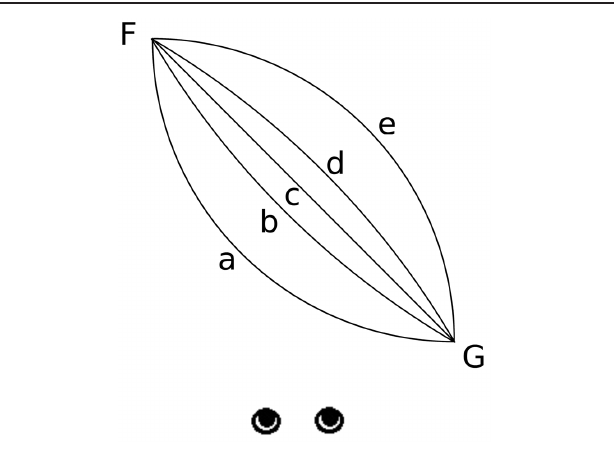
FIGURE 1 | A top view of two convex trajectories differing in magnitude of curvature (a and b), one linear trajectory (c) and two concave trajectories differing in magnitude of curvature (e and d) with the same magnitude as trajectories (a) and (b), respectively. In Experiment 1, the object moved from position F to position G. In Experiment 2, the object either moved from position F to G or moved from position G to F. The orientation of the diagonal path was the same in both